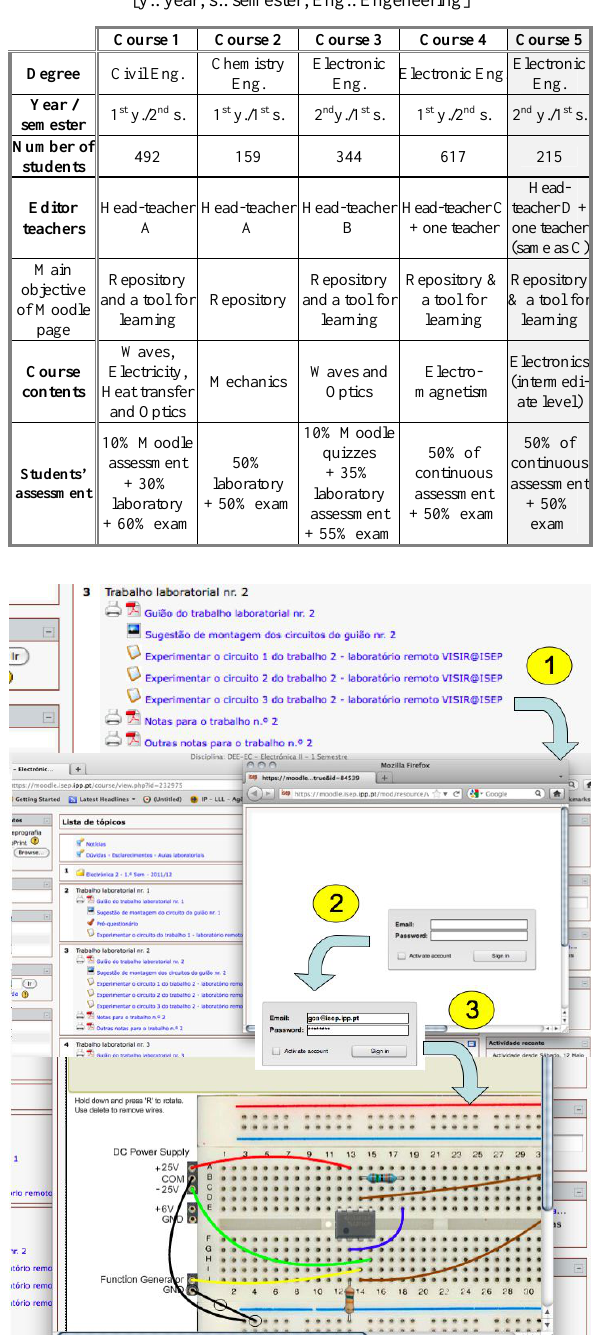
Figure 1. Accessing a remote experiment in VISIR through a direct link in a Moodle course